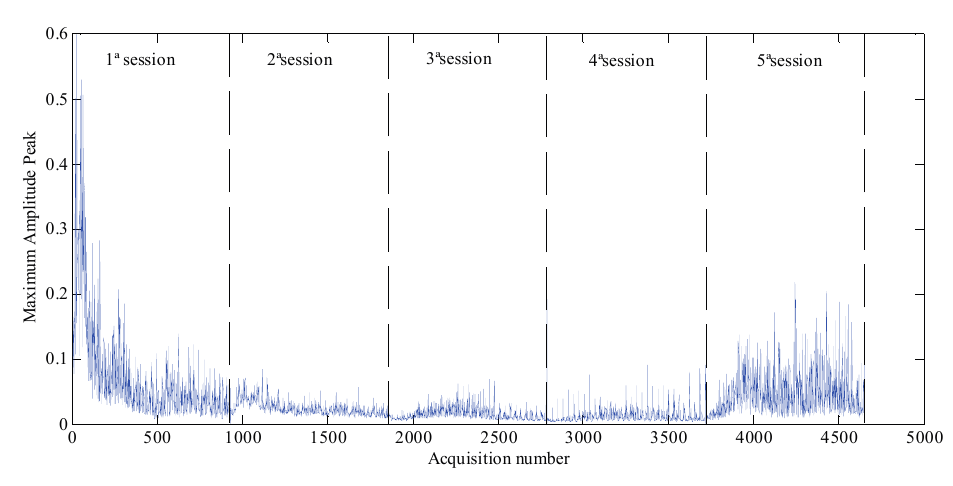
Figure 3. Maximum amplitudes of FFT power spectral of acoustic emission (AE) signal (60,000–100,000